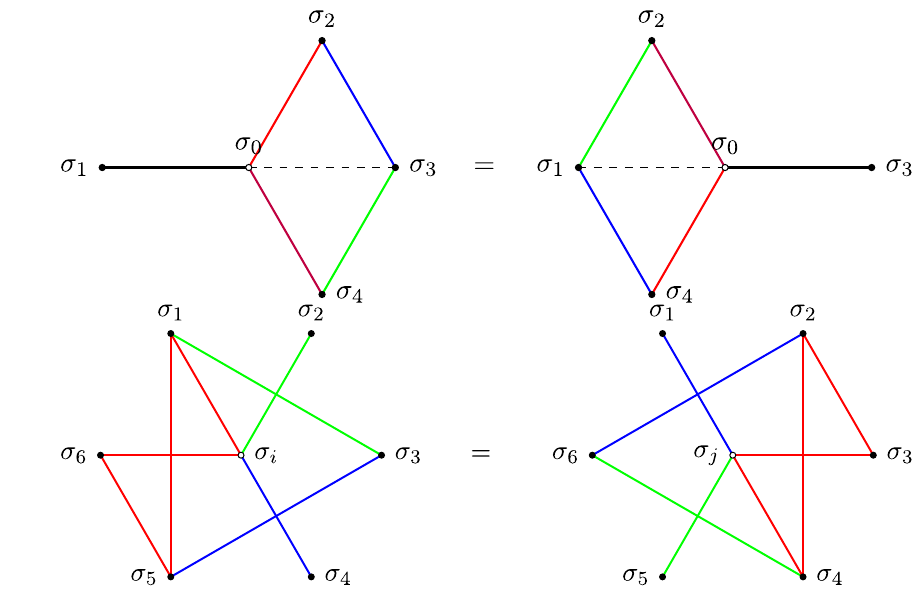
via the star-star relation. Spin variables live on vertices and interact via